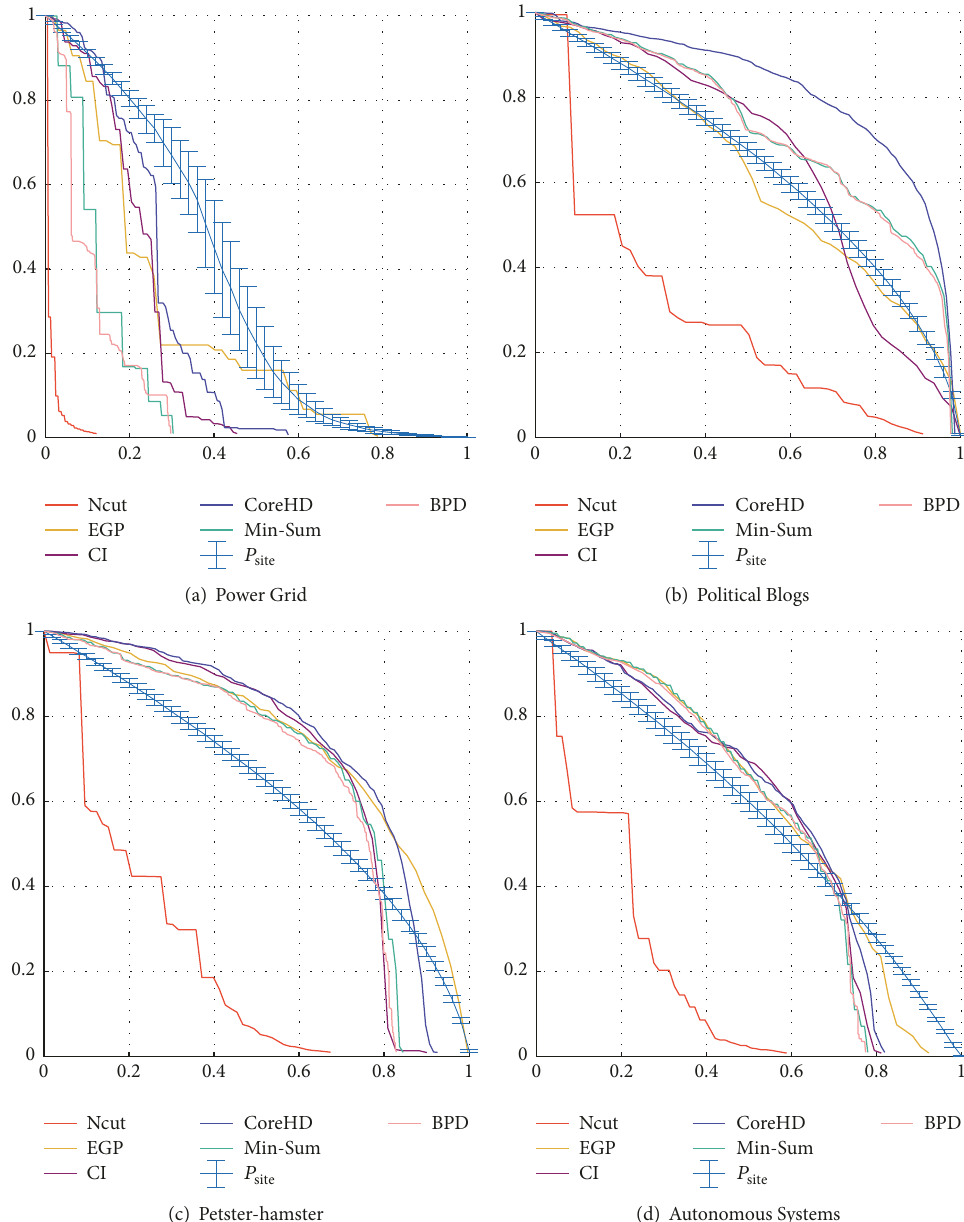
Figure 1: The size of the GCC of the networks versus the link removing proportion, comparing with classical node removal-based methods on real networks. The results of the site percolation are obtained after 100 independent runs. Table 2: DCFE, that is, the area under the curve of the size of the GCC after attacking by different algorithms. 𝑃 𝑃 for bond percolation, Betw for betweenness, and Bridg for bridgeness. The best performing algorithm in each row is emphasized in bold. bond